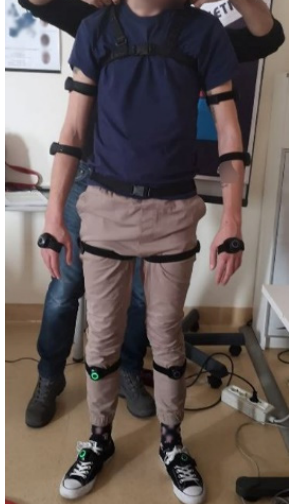
Figure 7. Physiotherapist wearing the motion capture device.